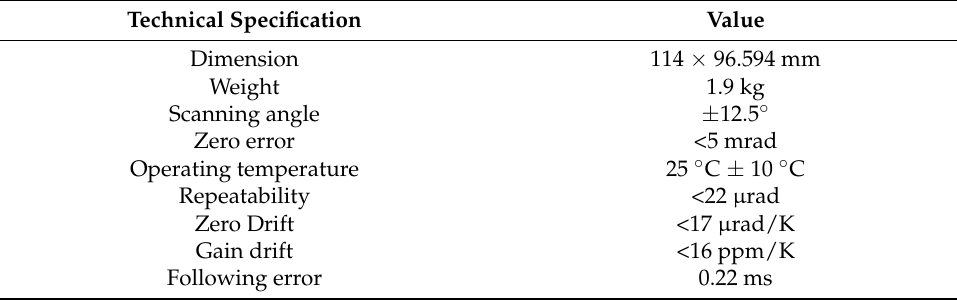
Table 1. Technical specifications of the laser scanning galvanometer.